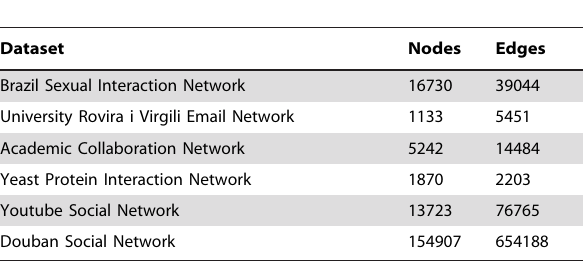
Table 4. Dataset Information.